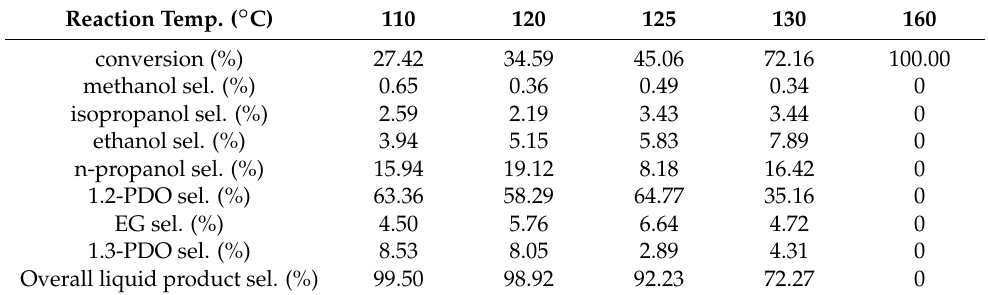
Table 1. Effects of reaction temperature on glycerol conversion and diol/alcohol selectivities. Reaction Temp. ( ◦